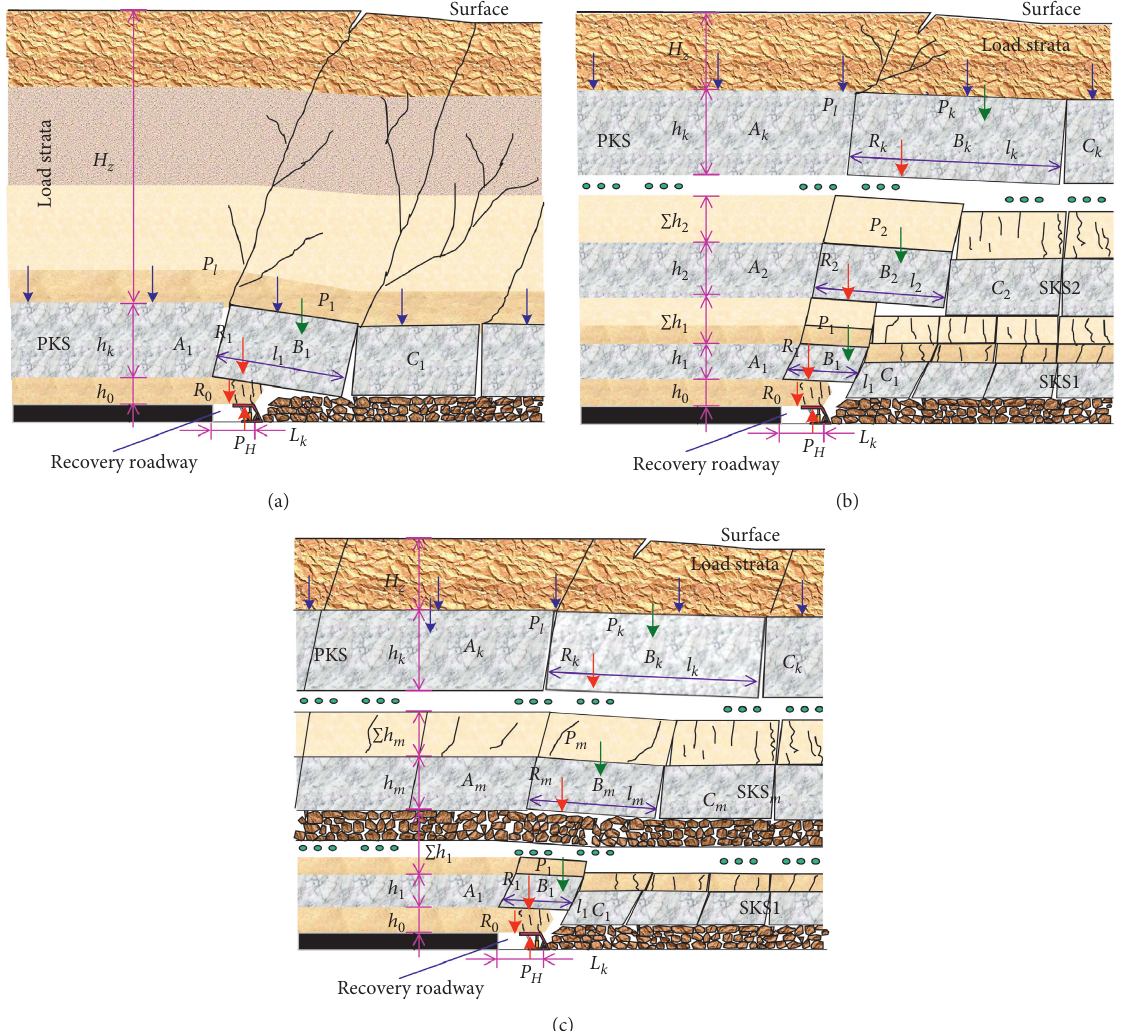
Figure 5: Mechanical models of the roof structure during periodic weighting: (a) instability mechanics model of a single-key stratum structure; (b) instability mechanics model of a multikey strata structure; (c) instability mechanics model of a single-key stratum structure of an over-seam extracted